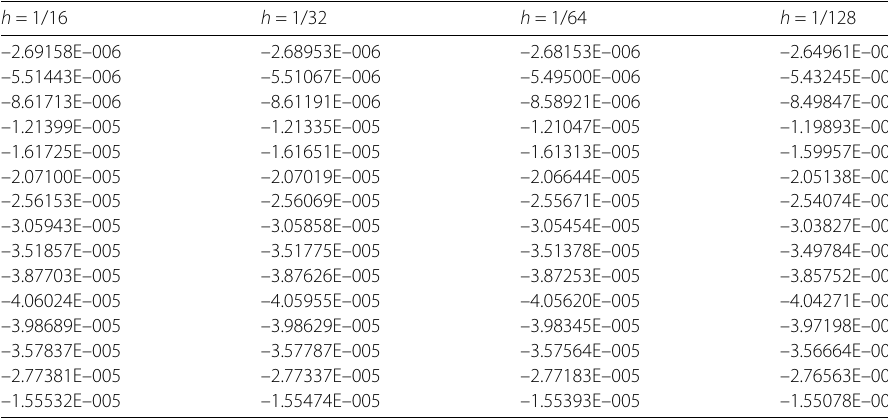
Table 2 Solutions on the line y = 0 of Problem